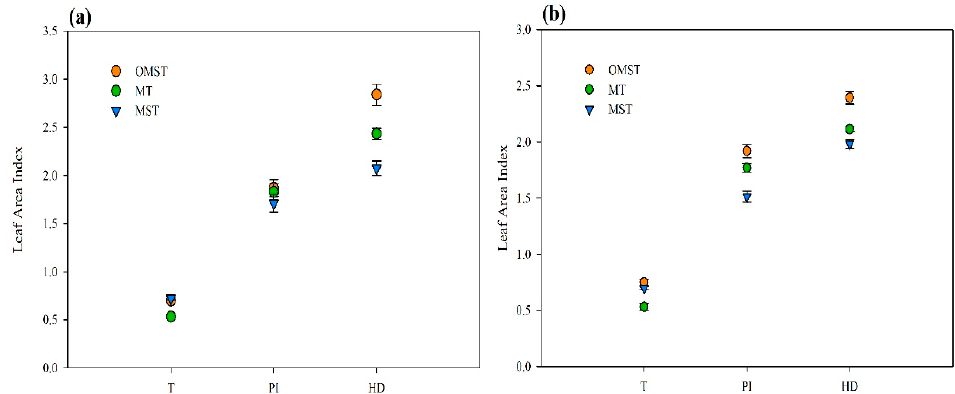
Figure 8. The leaf area index at different growth stages under different rice establishment methods: ( a ) Xiangzaoxian24; and ( b ) Zhongzao39. OMST: Orderly mechanical seedling throwing, MT: Man- ual transplanting, MST: Manual seedling throwing, XZX24: Xiangzaoxian24, ZZ39: Zhongzao39, T: Middle tillering stage, PI: Panicle initiation stage, HD: Heading stage. Error bars above mean indicate standard error ( n = 3).